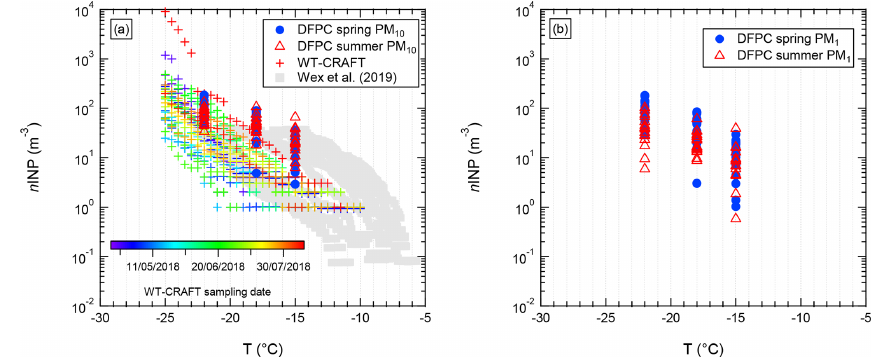
Figure 2. Ambient n INP as a function of the activation T assessed for samples from GVB during 2018 by DFPC and WT-CRAFT. DFPC data are divided into spring (blue) and summer (red) samples, while WT-CRAFT data are color-coded according to the sampling date. (a) PM 10 (DFPC) and TSP (WT-CRAFT) data. (b) PM 1 data (available only for DFPC). For comparison purposes, the data from Wex et al. (2019b), which refer to PM 10 samples, are also reported in panel (a) (Wex et al.